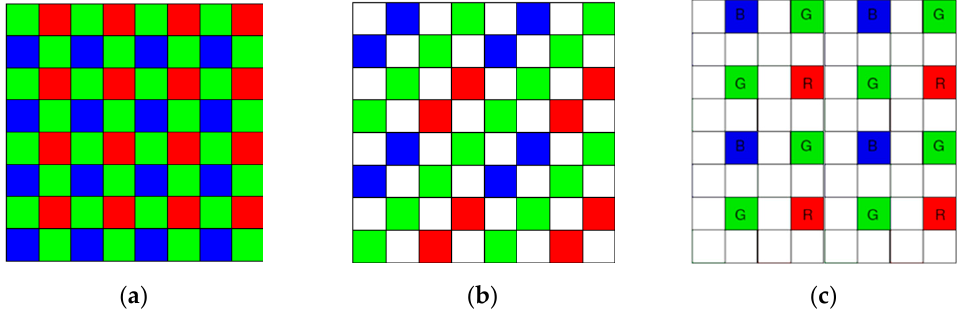
Figure 1. Three CFA patterns. ( a ) CFA 1.0; ( b ) CFA 2.0; ( c ) CFA 3.0.